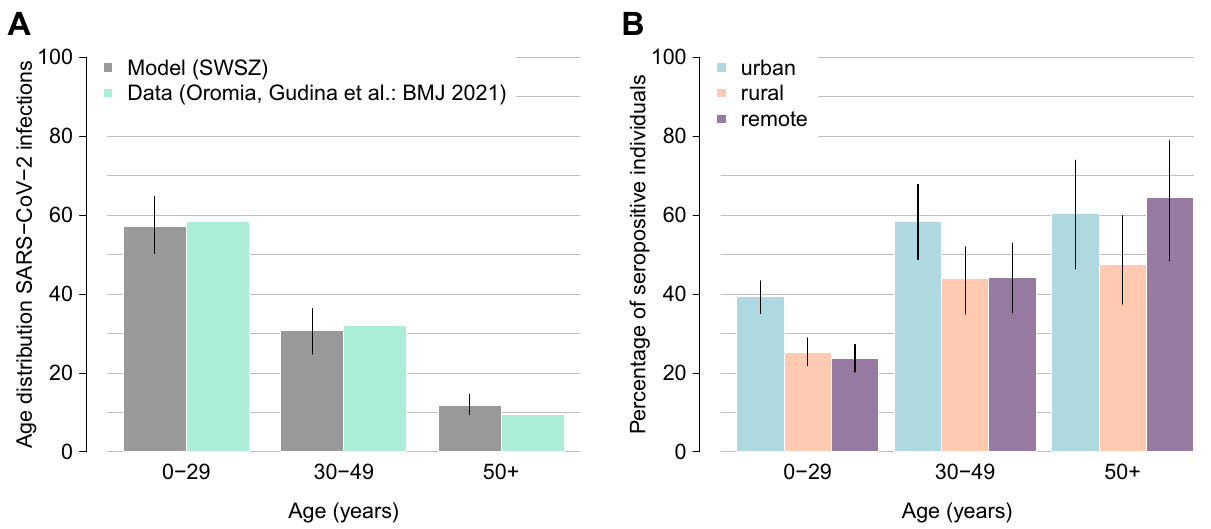
Figure 1. (A) Comparison between the age distribution of all confirmed cases reported between March and September 2020 in the Oromia Region 38 and the age distribution of the cumulative infections as obtained with a model mimicking the school closure and the achievement of immunity levels estimated for the Jimma Zone in March 2021 37 . Aggregated model estimates for the entire SWSZ are obtained by considering the proportion of population living in remote settlements, rural villages, and urban neighborhoods of the SWSZ, their age structure, and the age-specific infection attack rate expected across the different social contexts before